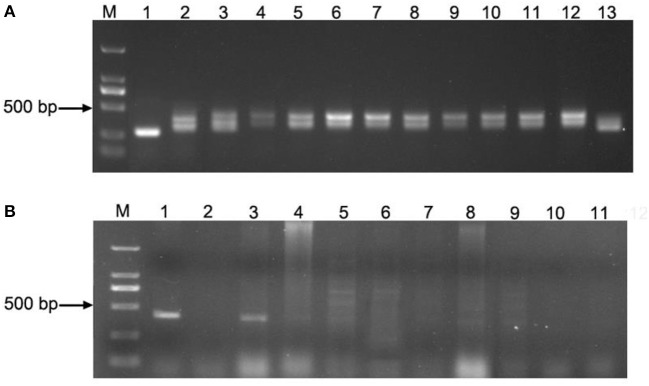
PCR amplification of TaVp1 and Tamyb10 sites in partial strains: TaVp1
(A) (M: DL2000 marker; 1: Ae. tauschii (282 bp); 2: Zhoumai 18 (423 bp); 3–13: partial strains of advanced backcross population.); Tamyb10
(B) (M: DL2000 marker; 1: Ae. tauschii (389 bp); 2: Zhoumai 18; 3–11: partial strains of advanced backcross population).